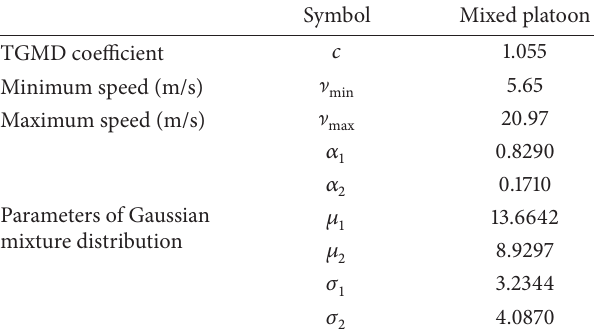
Table 3: Statistics of TGMD of Time Period